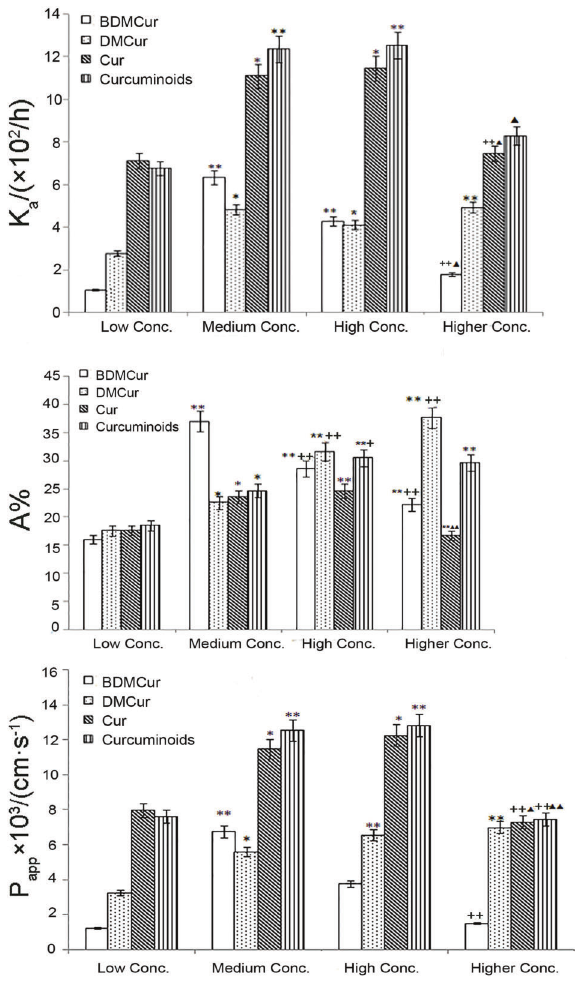
Figure 4. Absorption parameters of bisdemethoxycurcumin (BDMCur), demethoxycurcumin (DMCur) and curcumin (Cur) with different concentrations. Top : absorption rate constant (K a ); middle : absorption percentage (A%); and bottom : drug apparent absorption coef fi cient (P app ). Conc: concentration. **P o 0.01, *P o 0.05 compared to low concentration; ++ P o 0.01, + P o 0.05 compared to medium concentration; mm P o 0.01, m P o 0.05 compared to high concentration